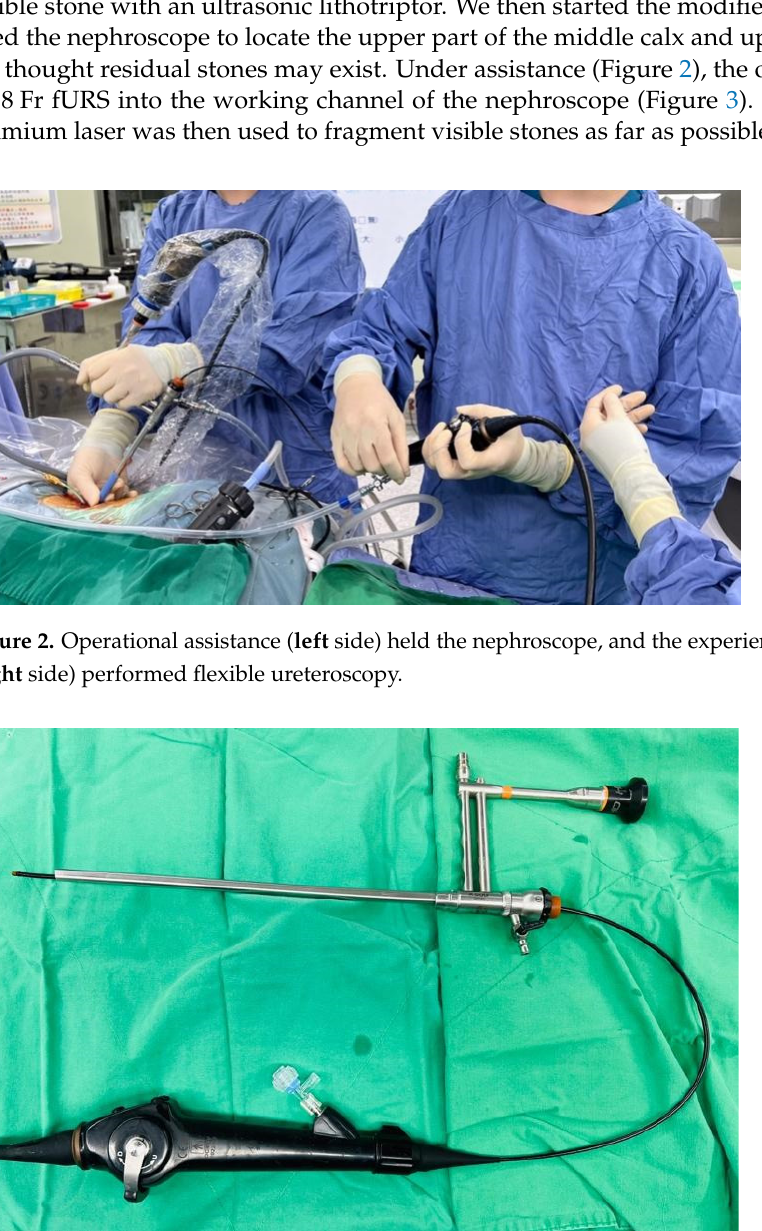
Figure 3. 8 Fr flexible ureteroscope was placed into the working tract of a nephroscope.